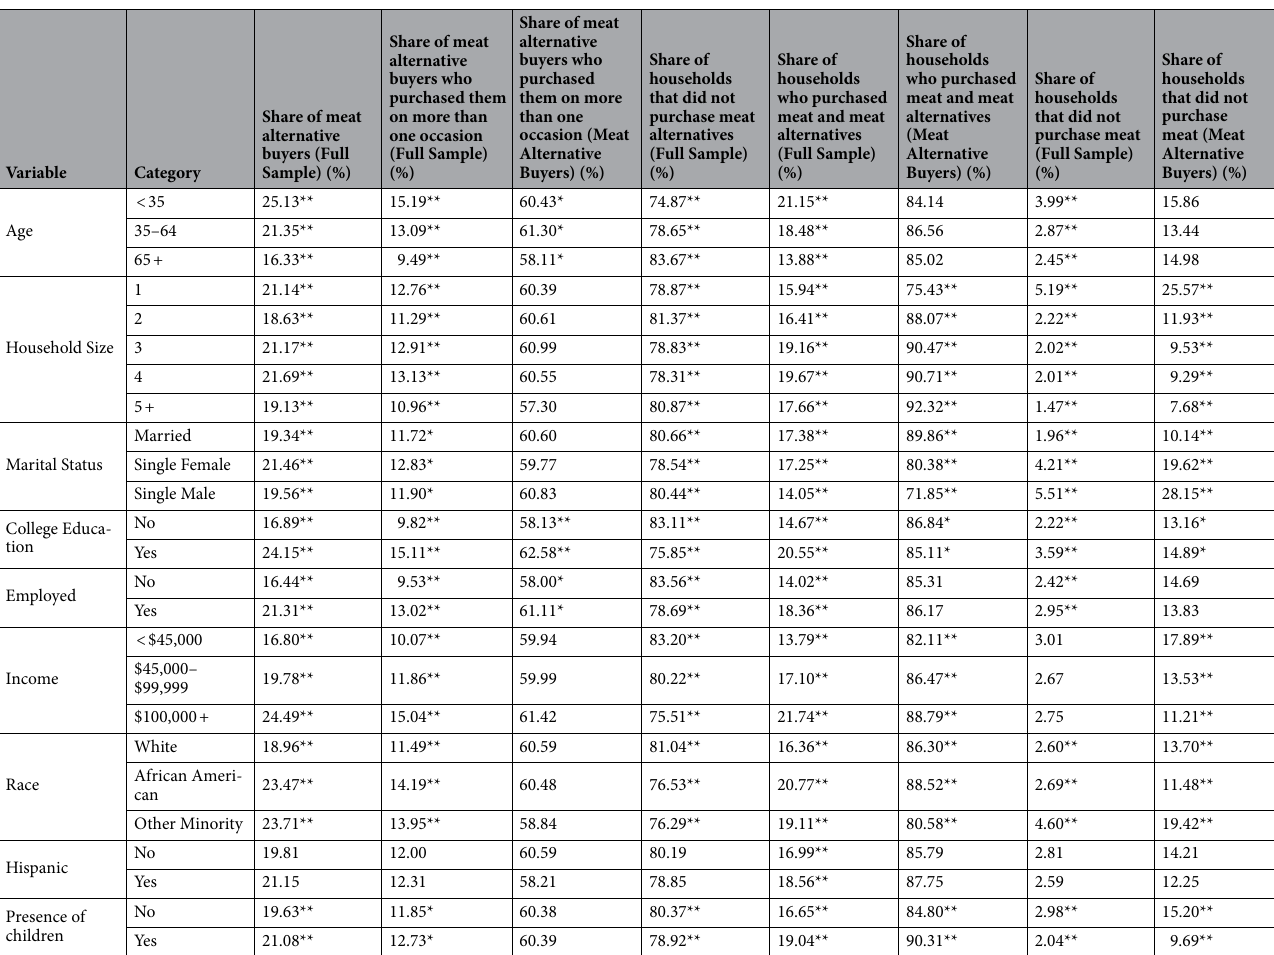
Table 1. Meat alternative buying behavior by demographic category. Chi-Square tests were used to test the differences in group probability between each demographic category with the null hypothesis stating there is no association between the demographic category and the outcome. The sample used for the statistical test is denoted in parenthesis in the column description. A * denotes significance at the 5% level and **denotes significance at the 1%